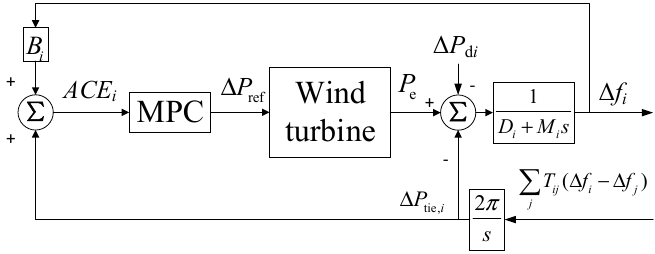
Figure 3. Block diagram of AGC system with wind power participation.